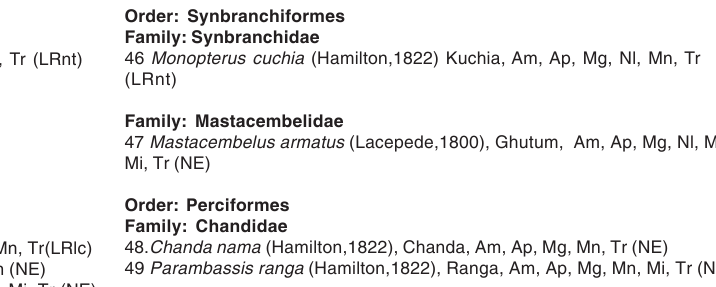
Order: Perciformes Family: Chandidae